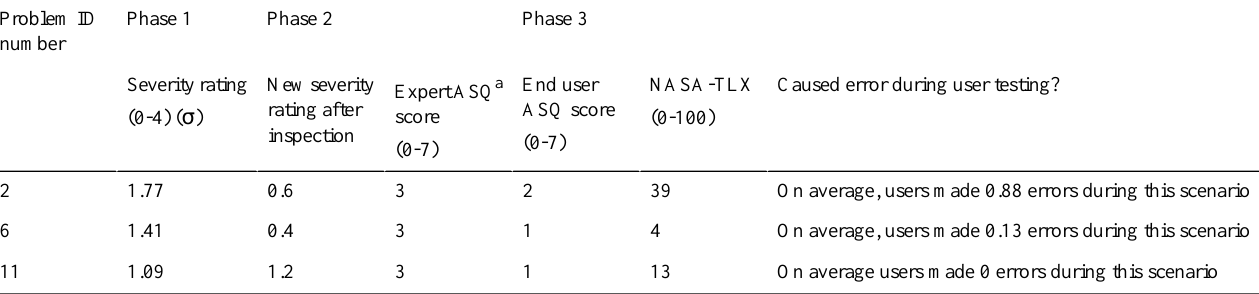
Table 16. Presents the evolution of three distinct problems through the testing lifecycle with the usability metrics taken at each stage.